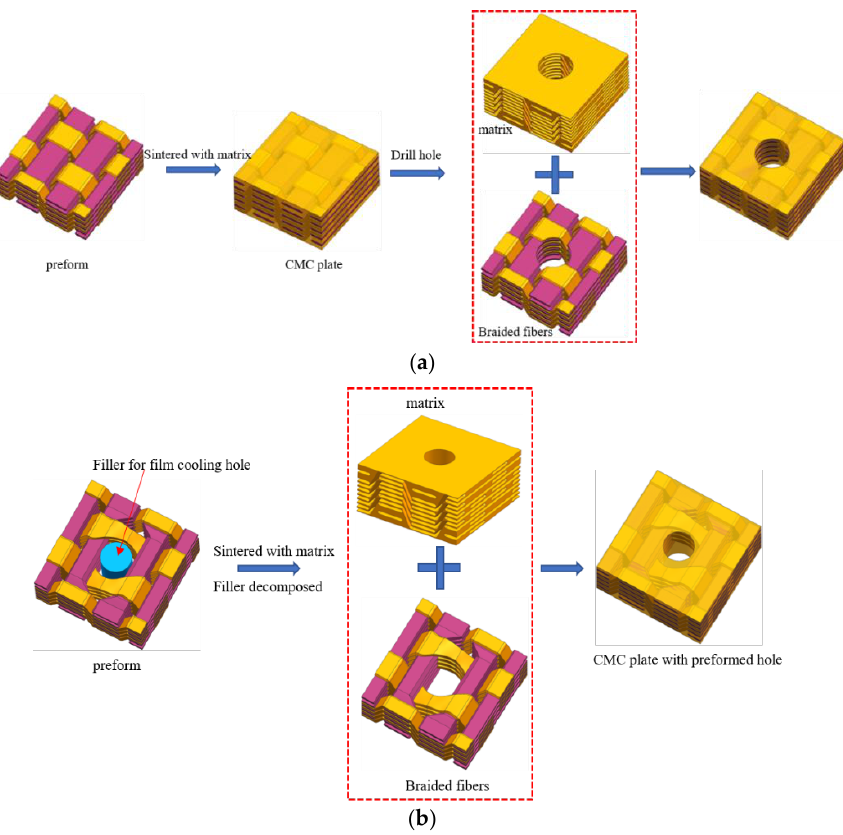
Figure 2. The different manufacturing schematic diagrams for film-cooling holes: ( a ) the manufacturing schematic diagram of the drilled hole; ( b ) the manufacturing schematic diagram of the preformed hole.